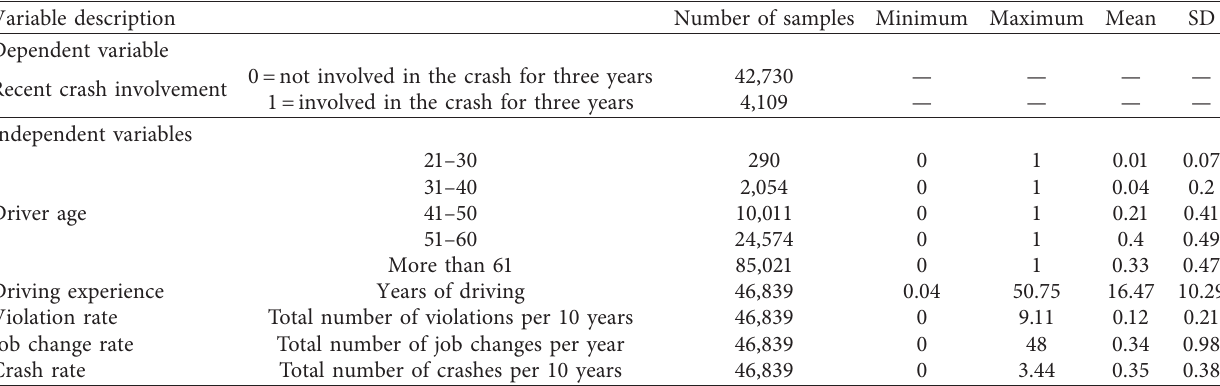
Table 2: Descriptive statistics of variables for express bus.